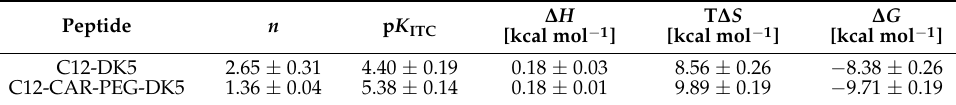
Table 6. Thermodynamic parameters of binding C12-DK5 and C12-CAR-PEG-DK5 peptides to POPC LUVs at 25 ◦ C.